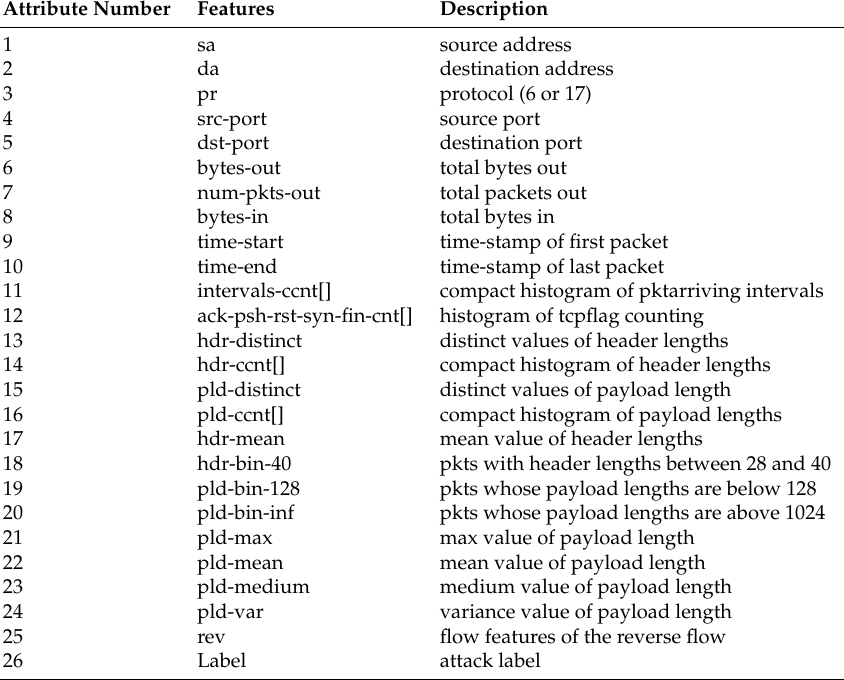
Table 9. NetML-2020 dataset features’ list with